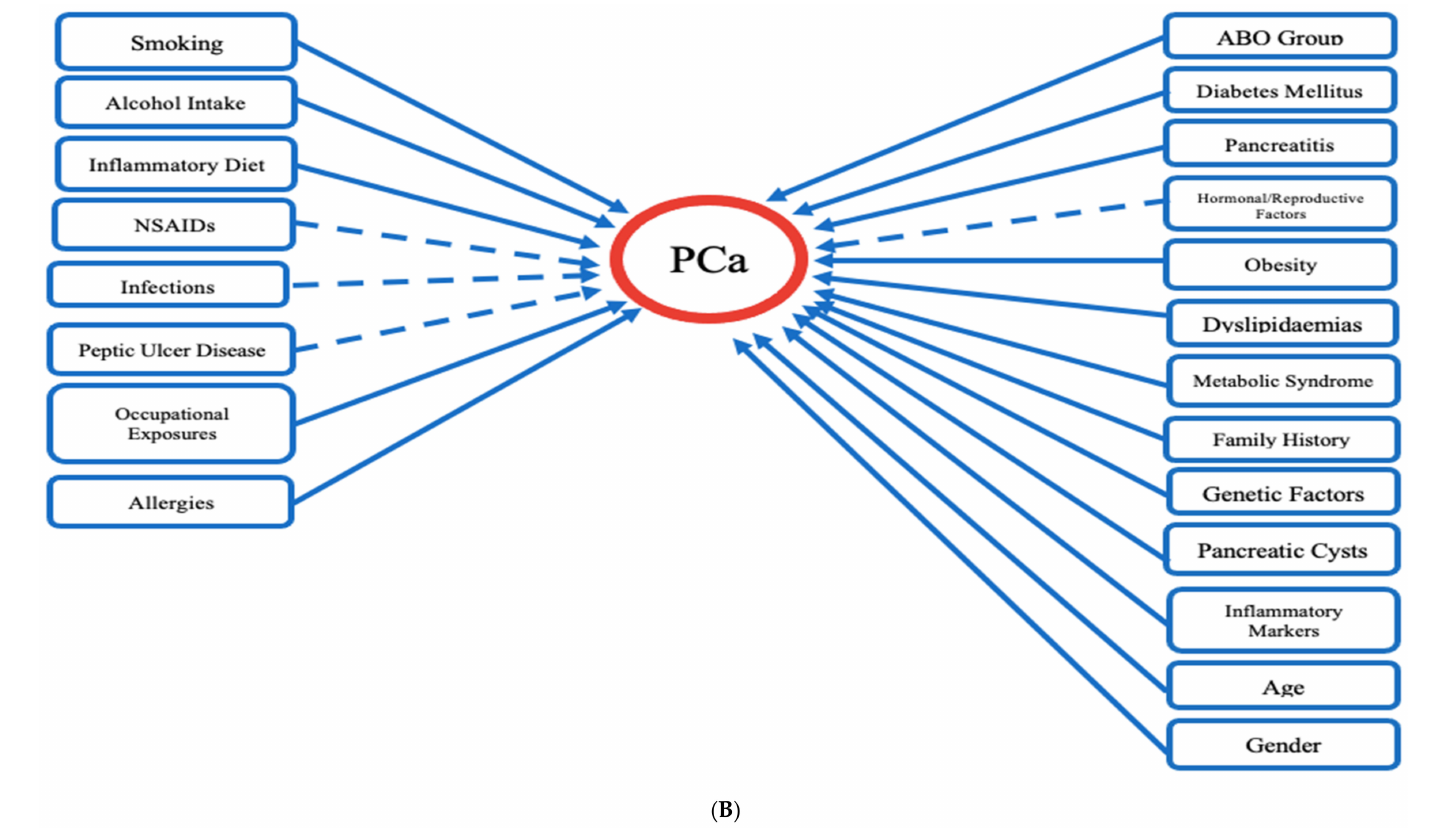
Figure 4. ( A ) Schematic representation of exposure variables included in the current study and their interactions *. * All variables are hypothesized risk factors for pancreatic cancer (PCa) risk (illustrated in red). Blue variables illustrate specific external risk factors; green variables illustrate internal risk factors; orange variable illustrates the inflammation pathway; purple variable illustrate the immune response pathway. The blue arrow illustrates a direct unidirectional association between variables and PCa; the orange arrow illustrates variables associated with the inflammation pathway; the purple arrow variables associated with the immune response; the yellow arrows bidirectional association between variables and PCa. ( B ) Schematic representation of the strength of the association with PCa of the risk factors identified in this systematic review. Strength of the association is defined considering the number of studies investigating the exposure, the range of the hazard ratio/odds ratio/relative risk/standardized incidence ratio reported in each study, and the statistical significance. * All variables are risk factors for pancreatic cancer (PCa) risk (illustrated in red). Bold arrows illustrate a strong association between variables and PCa risk. Large-dotted arrows illustrate variables with intermediate associations. Short-dotted arrows illustrate variables with weak